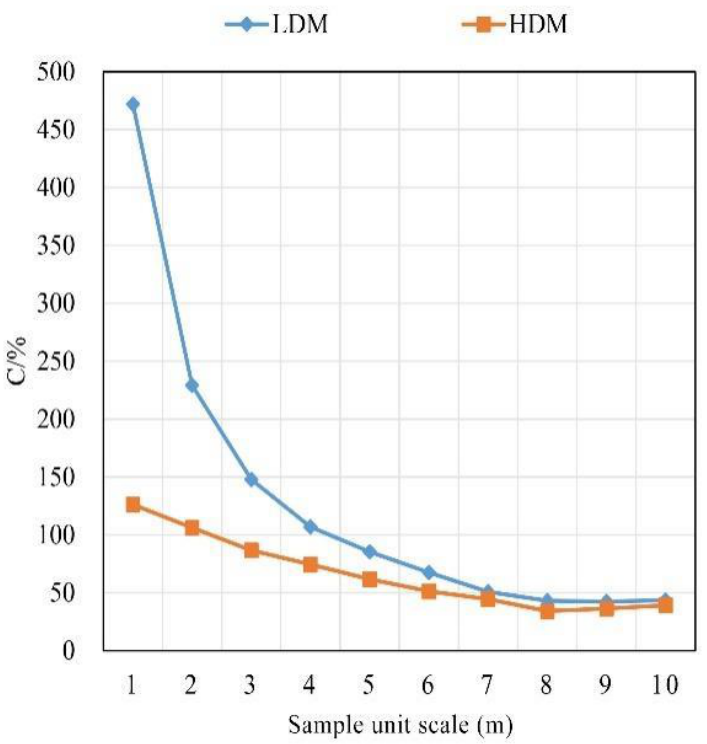
Figure 6. Trends of the coefficient of variation for AGB under different models.